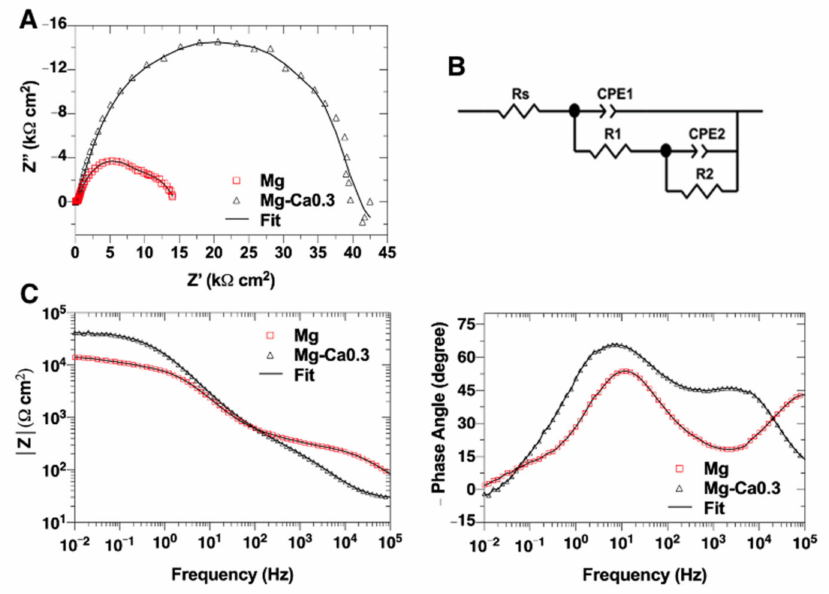
Figure 9. ( A ) Nyquist diagrams of Mg and Mg-Ca0.3 exposed for 24 h to Hank’s physiological solution at 21 ◦ C; ( B ) equivalent circuits used to fit experimental EIS spectra; and ( C ) Bode diagrams.